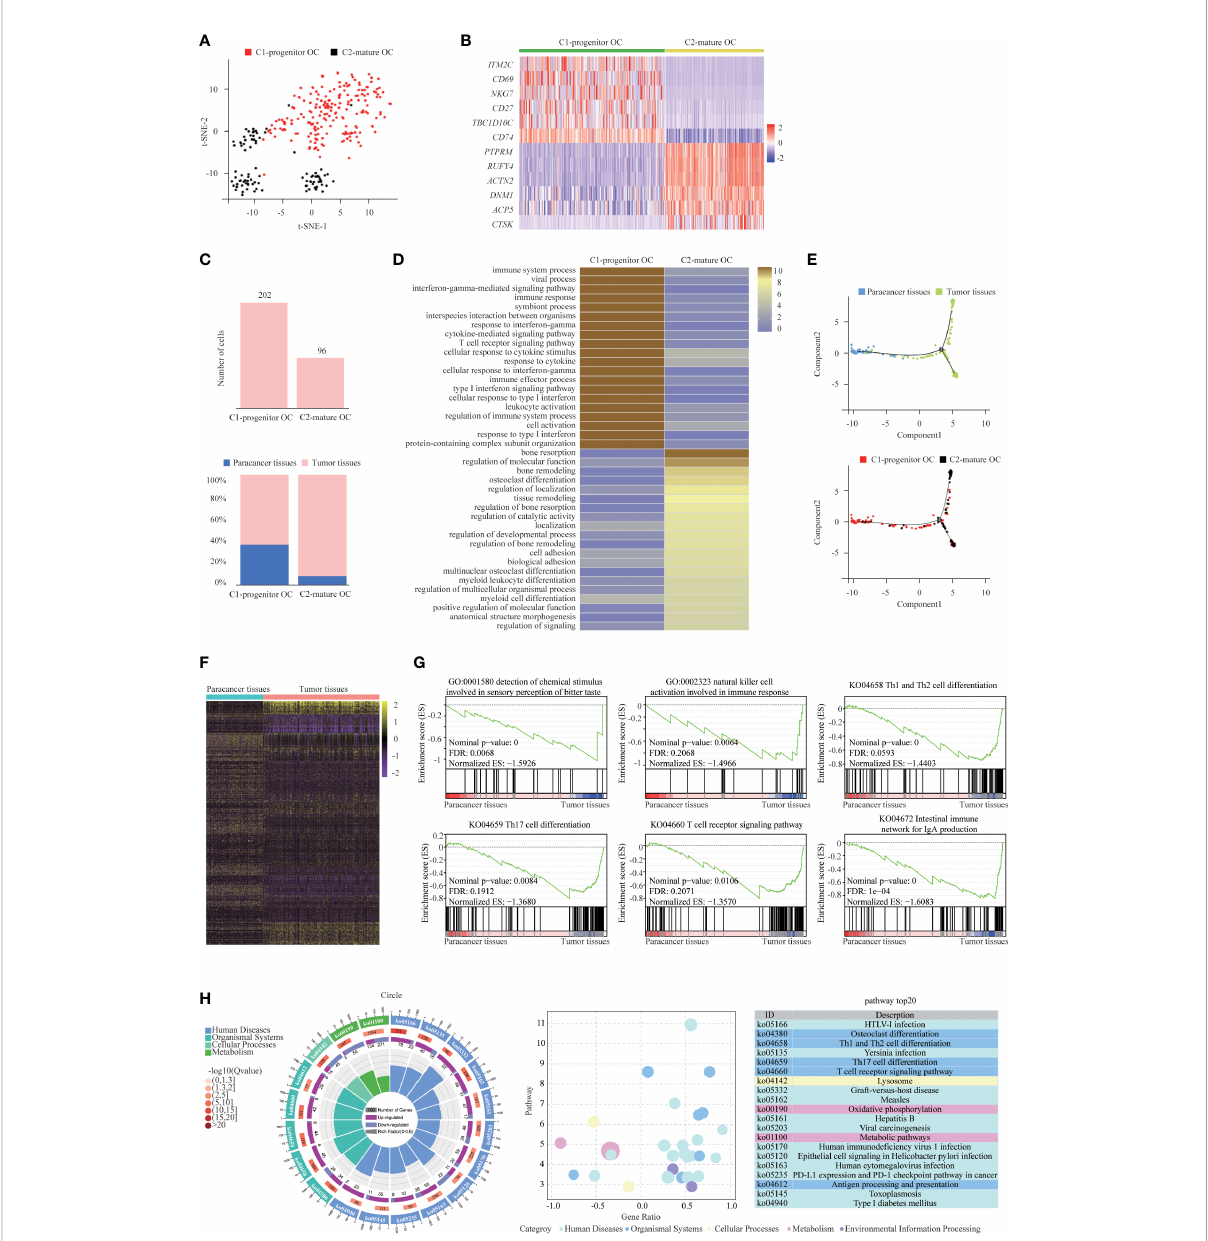
FIGURE 5 Two Distinct States of Tumor-Enriched Osteoclasts. (A) t-SNE plot showing the two main subsets of Osteoclasts. (B) Heatmap showing speci fi c marker genes in each Osteoclasts cluster. (C) The cell number and proportion of each Osteoclasts cluster. (D) Functional enrichment analysis of upregulated genes in each Osteoclasts cluster was performed with KEGG analysis. (E) The Monocle 2 trajectory plot showing the dynamics of C1-progenitor OC and C2-mature OC. (F) DEGs of Osteoclasts in tumor tissues vs paracancer tissues in SUPS was analyzed. (G) GSEA analysis was performed on Osteoclasts of tumor tissue vs paracancer tissue. (H) KEGG analysis of DEGs in Osteoclasts of tumor tissues versus paracancer tissues was performed. The fi rst lap indicates the top 20 KEGG terms and the number of the genes corresponds to the outer lap. The second lap indicates the number of genes in the pathway and Q values for enrichment of the upregulated genes for the speci fi ed pathway. The third lap indicates the ratio of the upregulated genes (deep purple) and downregulated genes (light purple). The fourth lap indicates the enrichment factor of each KEGG pathway. KEGG, Kyoto Encyclopedia of Genes and